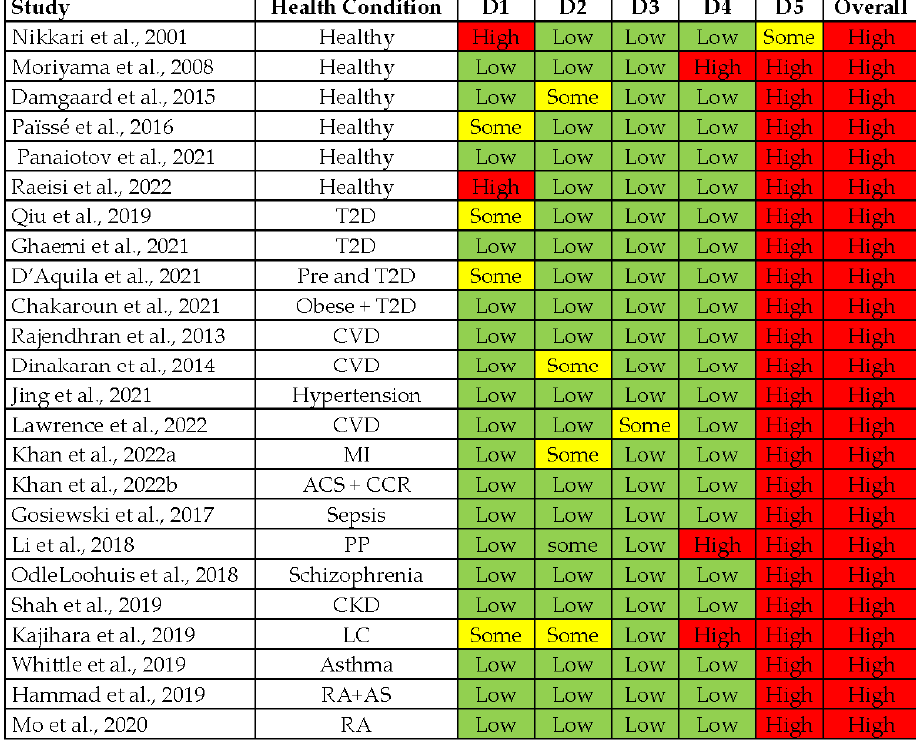
Figure 2. Assessment of study quality by using the Cochrane Checklist for Randomized studies. (Green is for Low, Yellow is for some and Red is for High).